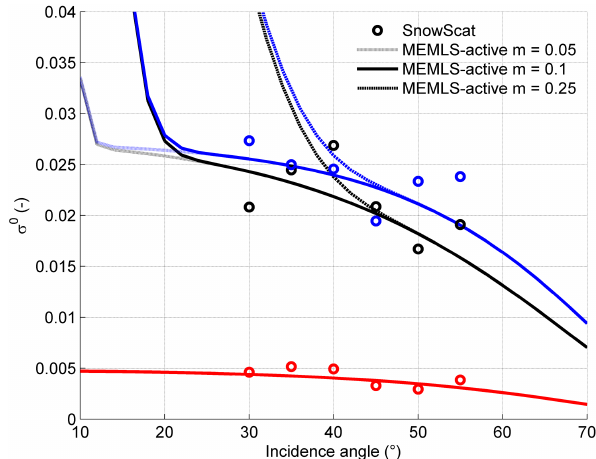
Figure 12. σ 0 measured by SnowScat (circles) and modeled by MEMLS3&a with CT input (lines) at 10.65GHz for different mean slope of surface undulations m . Colors represent polarization, with vv – black, hh – blue and hv – red. Best fit parameters according to Fig. 7.